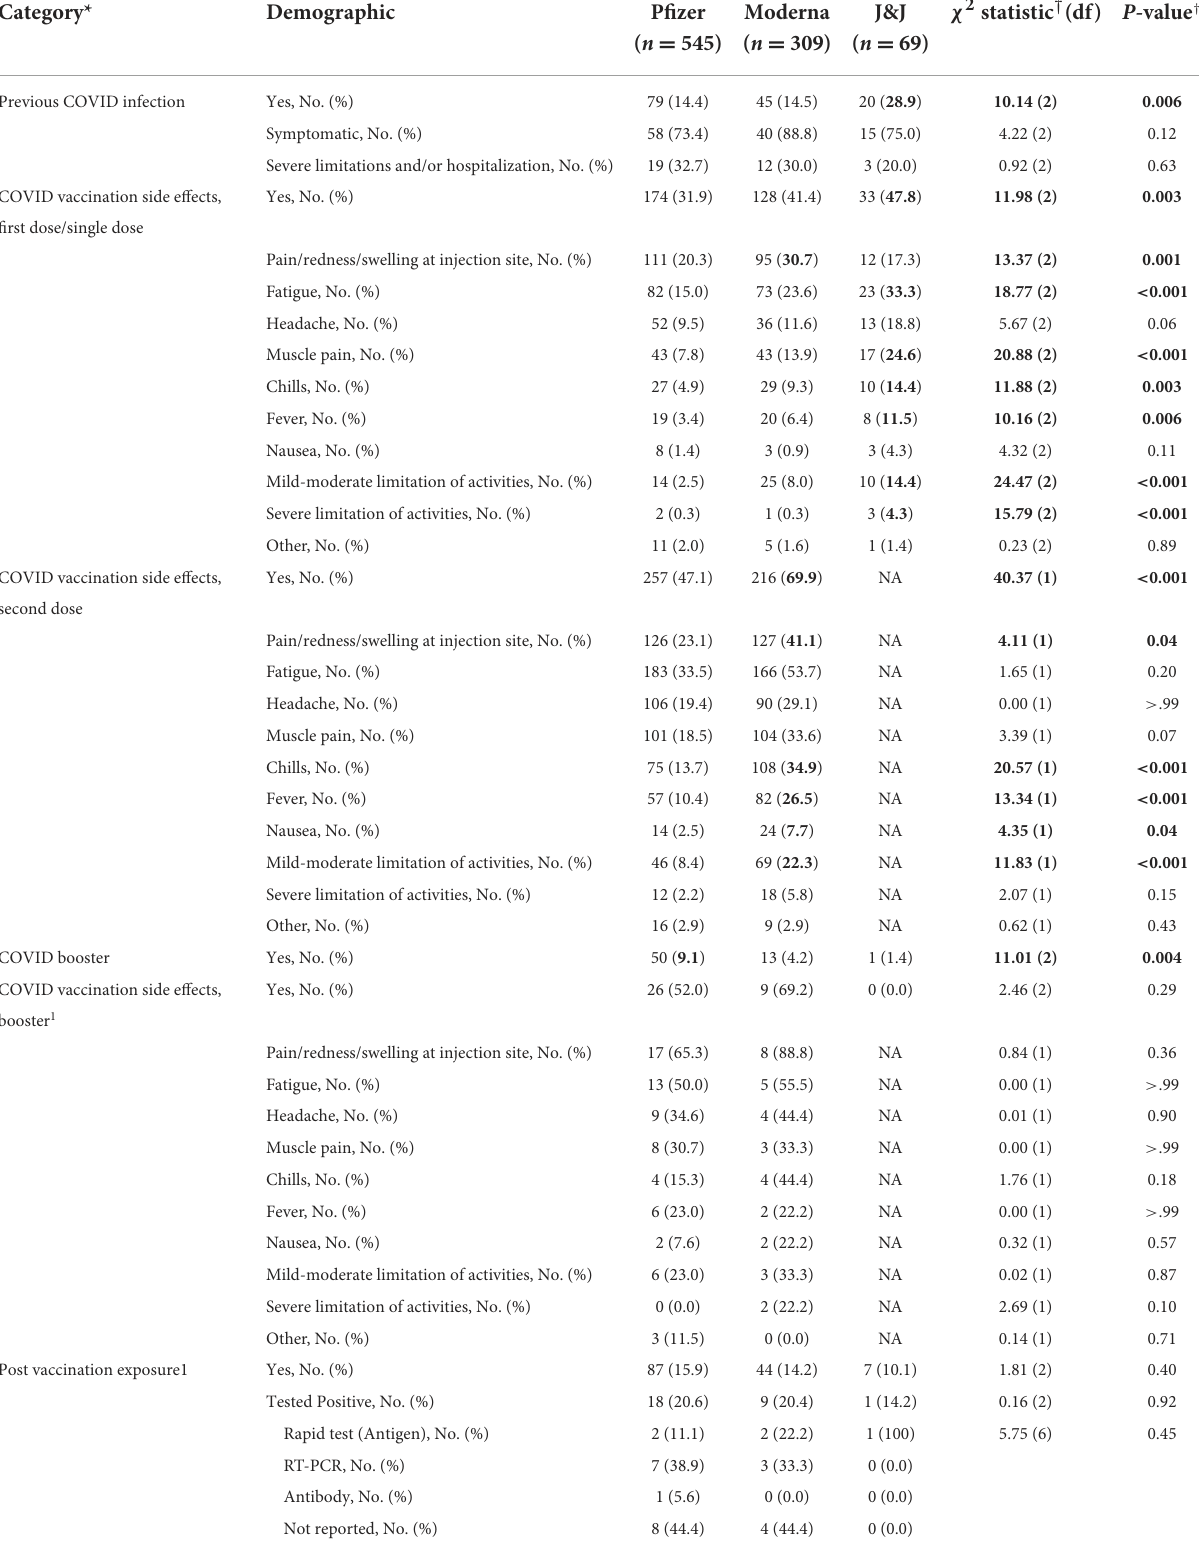
TABLE 3 COVID-19 and side effects by vaccine